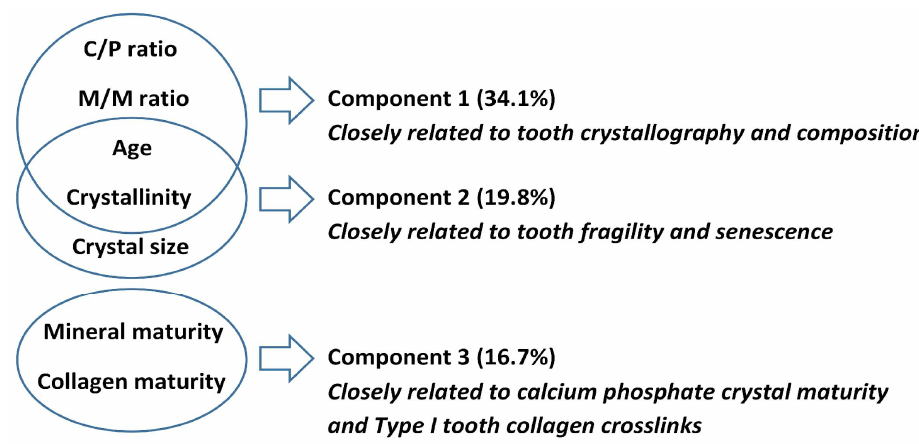
Figure 4. Component analysis explaining PMI in human teeth.